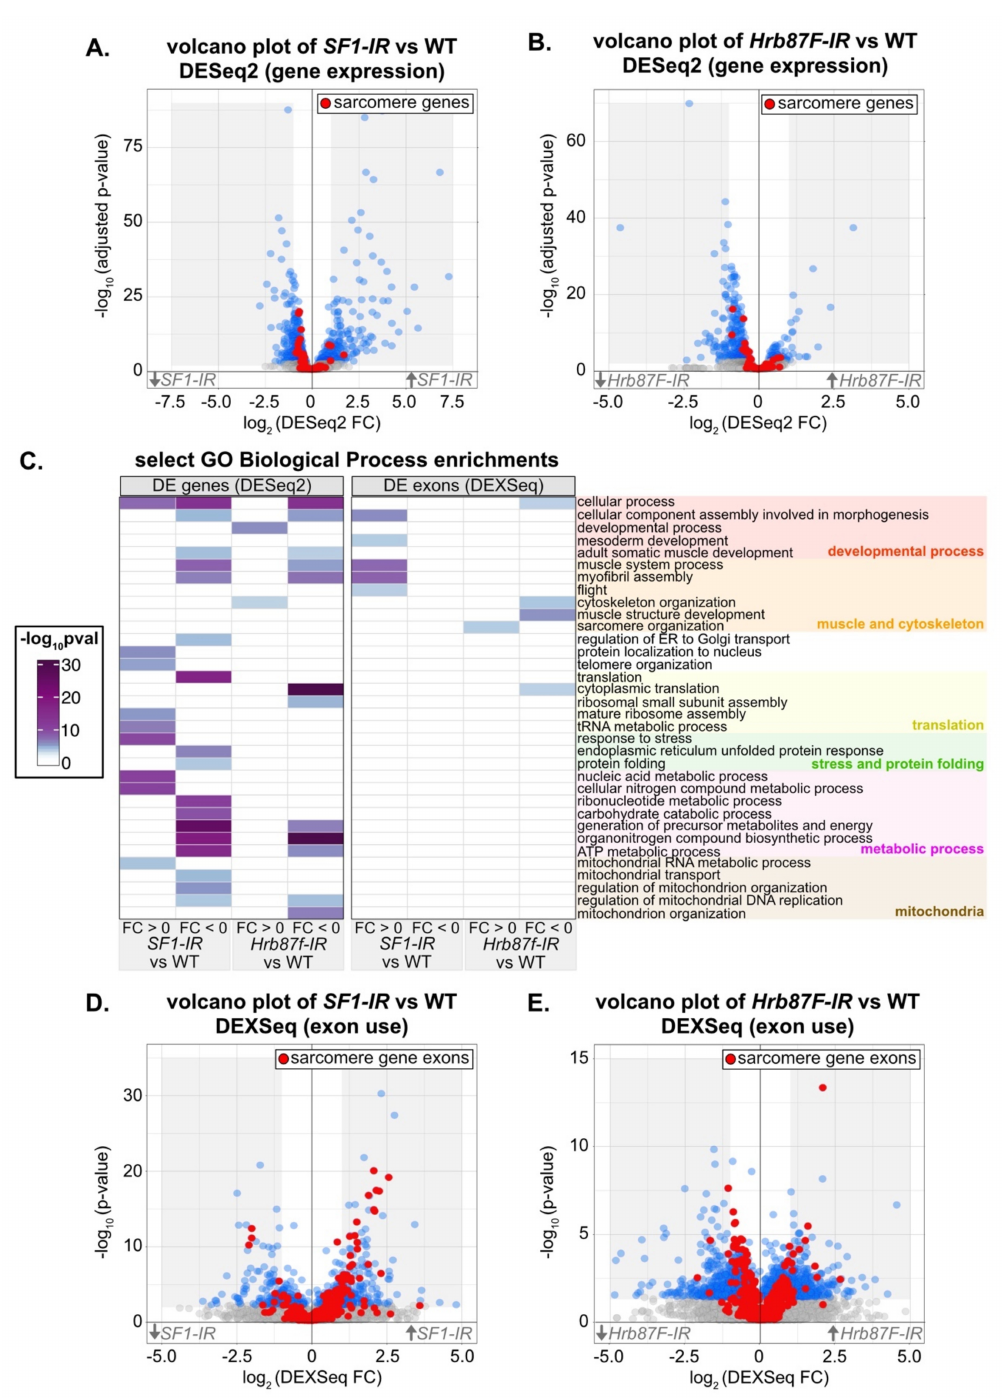
Figure 7. Knockdown of SF1 and Hrb87F alters exon usage of sarcomeric genes. ( A ) Volcano plot of all DESeq2 gene expression data for SF1-IR versus WT IFM. Genes with an adjusted p value < 0.01 are marked in blue, and genes encoding sarcomere components are labeled red. The gray shaded region marks all genes with a fold change (FC) > 1 or < –1. ( B ) Volcano plot colored as in ( A ) of all DESeq2 gene expression data for Hrb87F-IR versus WT IFM. ( C ) Heatmap of select GO Biological Process term enrichments for up and downregulated genes and exons for SF1-IR and Hrb87F-IR versus WT IFM. A full list of terms can be found in Table S4. Terms are manually grouped into categories related to a developmental process (red), muscle and cytoskeletal organization (orange), translation (yellow), stress and protein folding (green), a metabolic process (magenta) or mitochondria (brown). ( D ) Volcano plot of DEXSeq changes in exon use for SF1-IR versus WT IFM. Exons with a p value < 0.01 are marked in blue, and exons from sarcomere genes are labeled red. The gray shaded region marks all exons with a FC > 1 or < –1. ( E ) Volcano plot colored as in ( D ) of DEXSeq exon use data for Hrb87F-IR versus WT